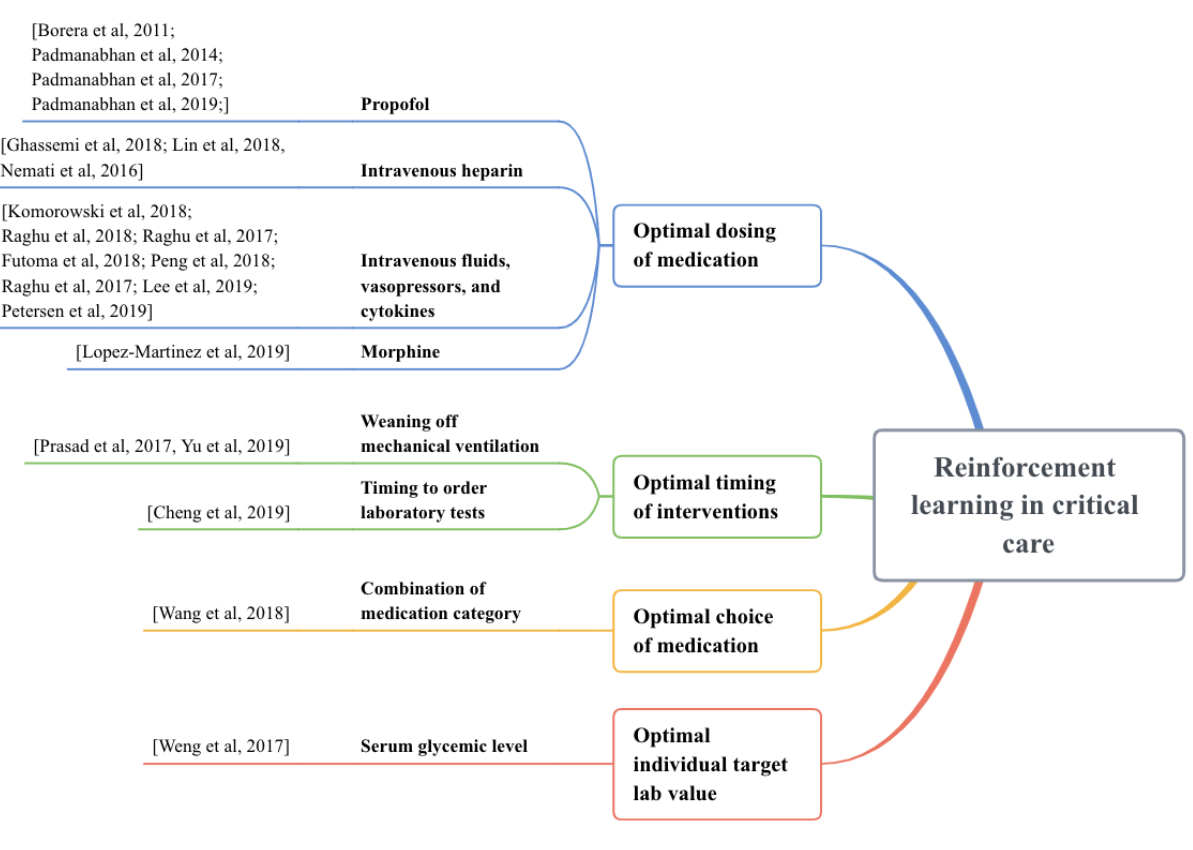
Figure 3. Mapping of reinforcement learning studies in critical care by application